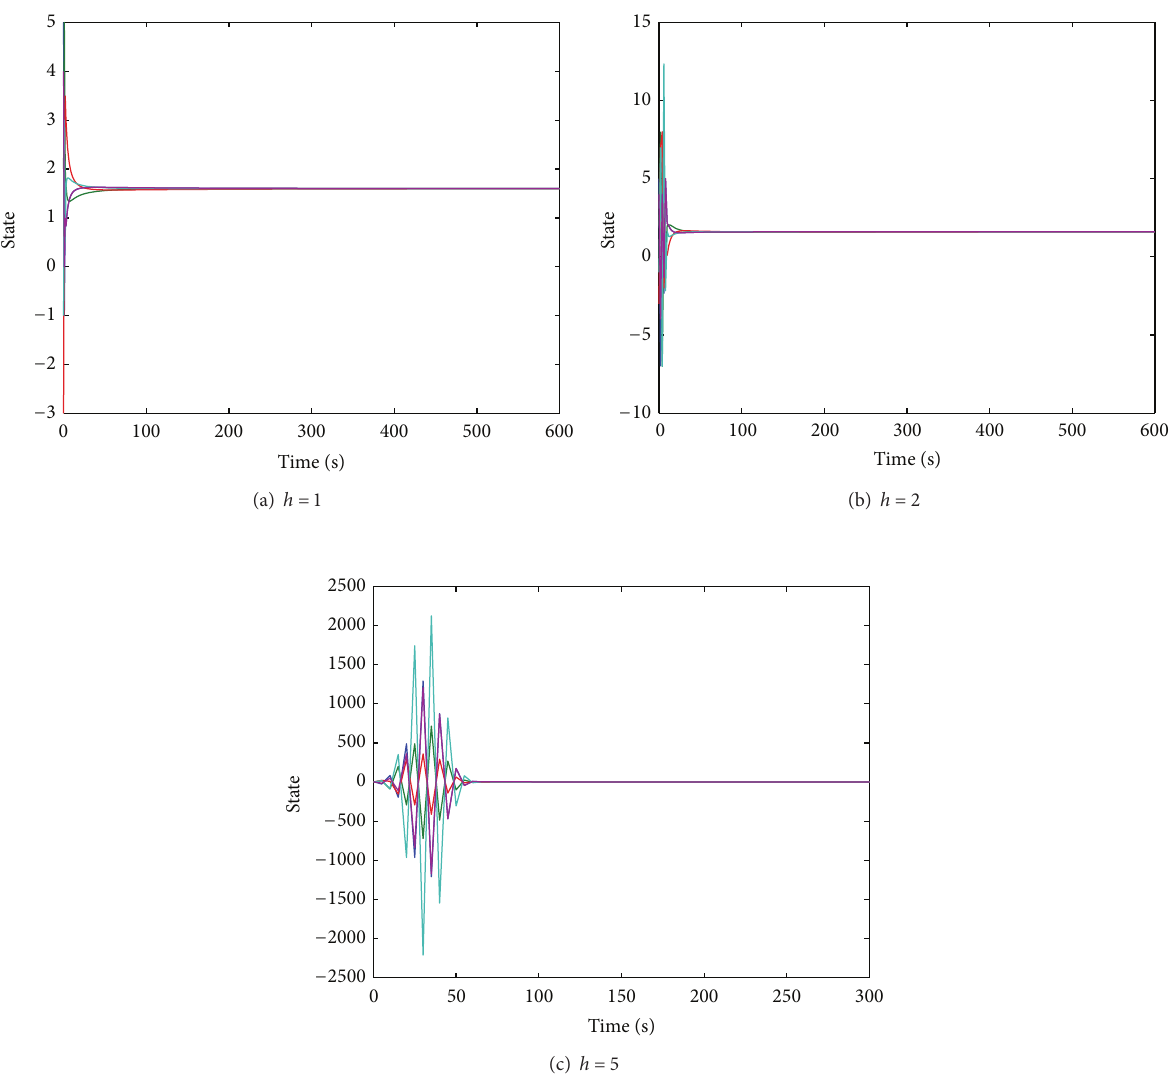
Figure 2: State trajectories under different sampling periods in the case of noise-free and fixed